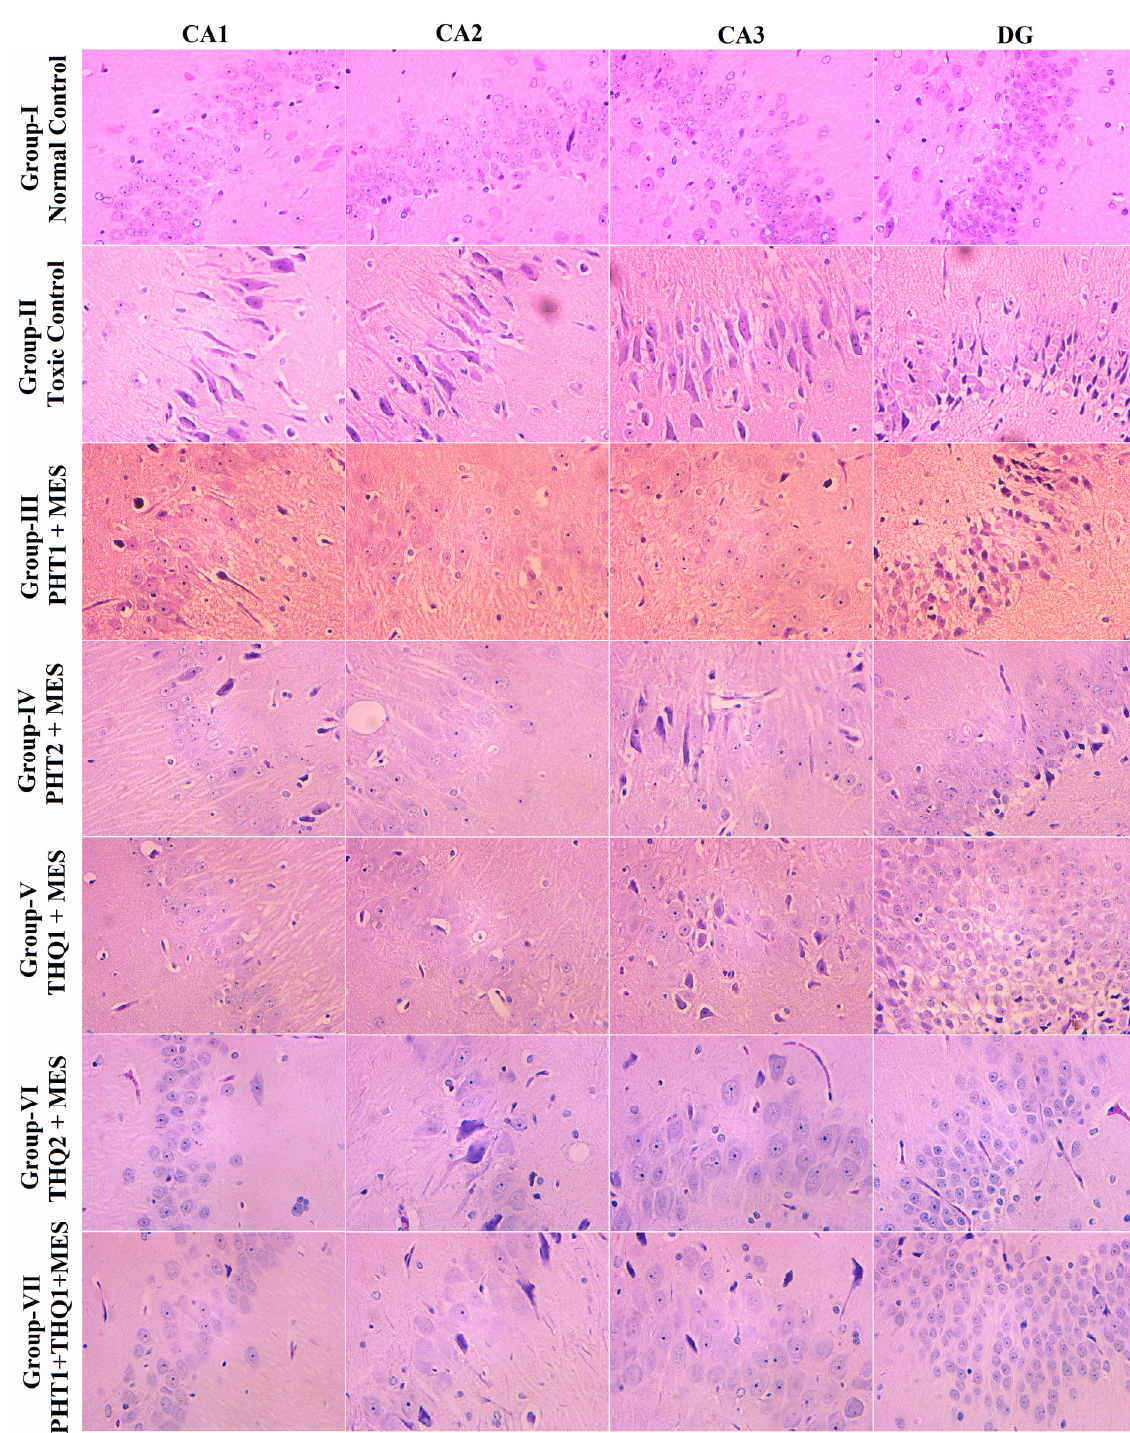
Figure 7. Illustrative photomicrographs depicting H/E-stained rat hippocampal sections revealing the effect of PHT (20 and 40 mg/kg), THQ (40 and 80 mg/kg), and PHT (20 mg/kg) + THQ (40 mg/kg) against electroshock-produced neuronal degeneration. MES (180 mA, 220 V for 0.20 s) reduced neuronal density in all hippocampal regions—CA1, CA2, CA3 and DG—and induced hefty pyknosis in the DG region (Group II). PHT (20 and 40 mg/kg) dose dependently resisted pyknosis, but neuronal loss is evident in all regions (Group III–IV). THQ (40 and 80 mg/kg) also resisted electroshock-induced neuronal damage (Group V–VI) in a dose dependent manner. The low dose synergistic regimen of PHT (20 mg/kg) and THQ (40 mg/kg) exhibited excellent neuroprotectant properties as evidenced by largely protected neuronal morphology and relatively high neuronal density with meagre pyknosis (Group-VII).